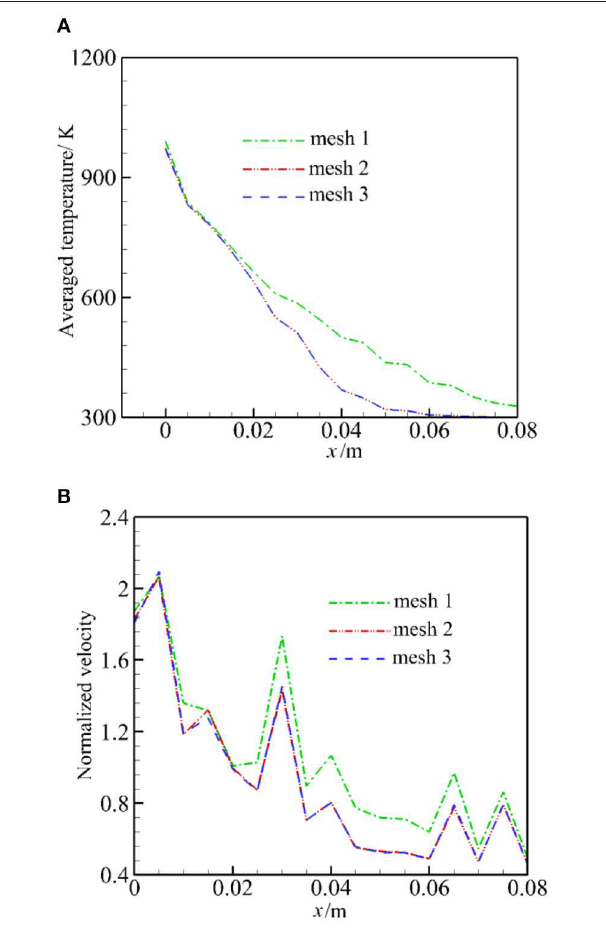
FIGURE 3 | Averaged temperature and normalized velocity for three mesh configurations. (A) Averaged temperature. (B) Normalized